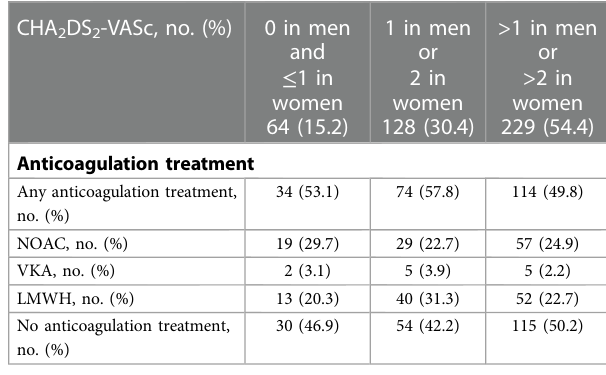
Table 3 Anticoagulation treatment in AF patients according to CHA 2 DS 2 - VASc score; n =421 a .